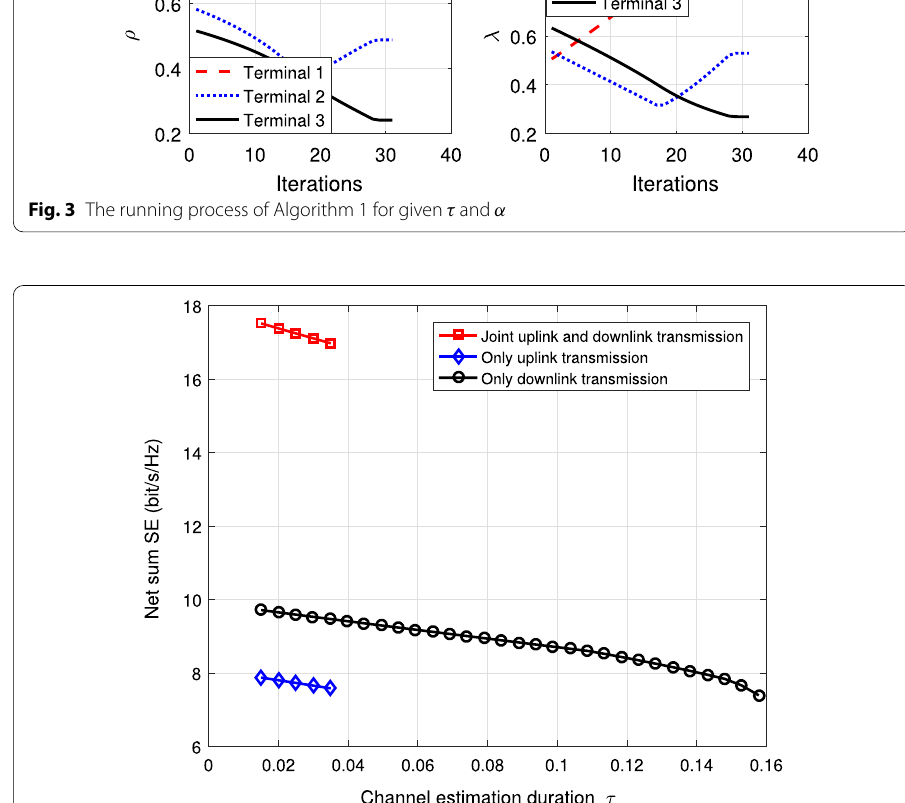
Fig. 4 Net sum spectral efficiency versus channel estimation